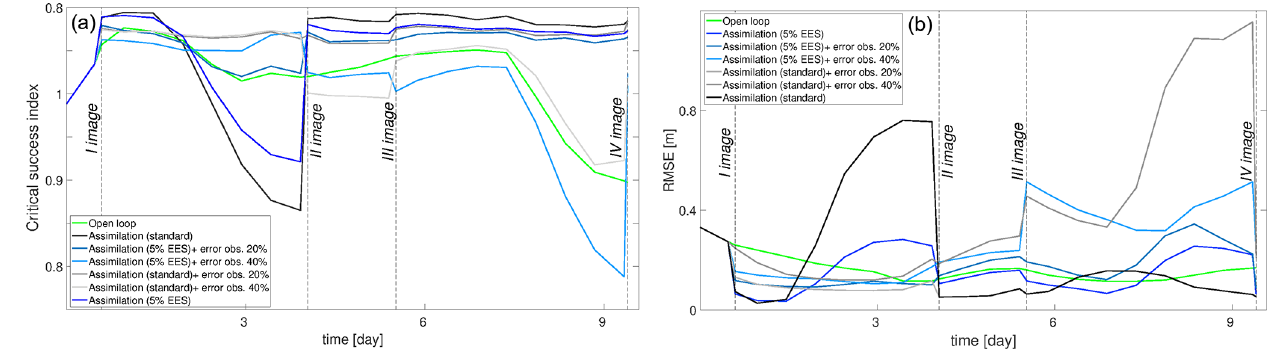
Figure 12. The CSI values (a) and RMSE (b) after the standard assimilation of SAR observations free of errors (black), with 20% errors (gray), and with 40% errors (light gray) as well as after the 5% EES assimilation free of errors (blue), with 20% errors (light blue), and with 40% errors